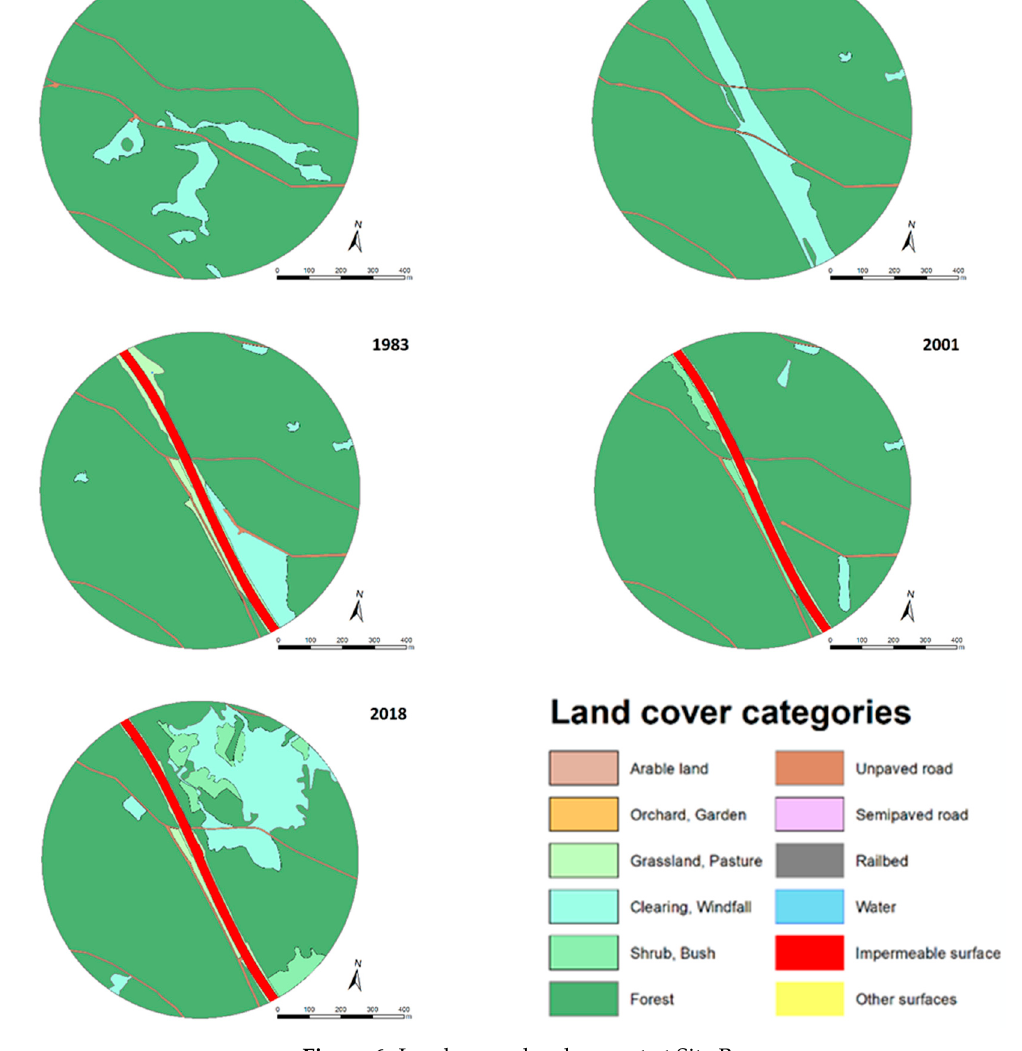
Figure 7. Proportion of individual hydrologic soil groups (HSG) types in the area of Site A ( a ) and their spatial distribution ( b ).